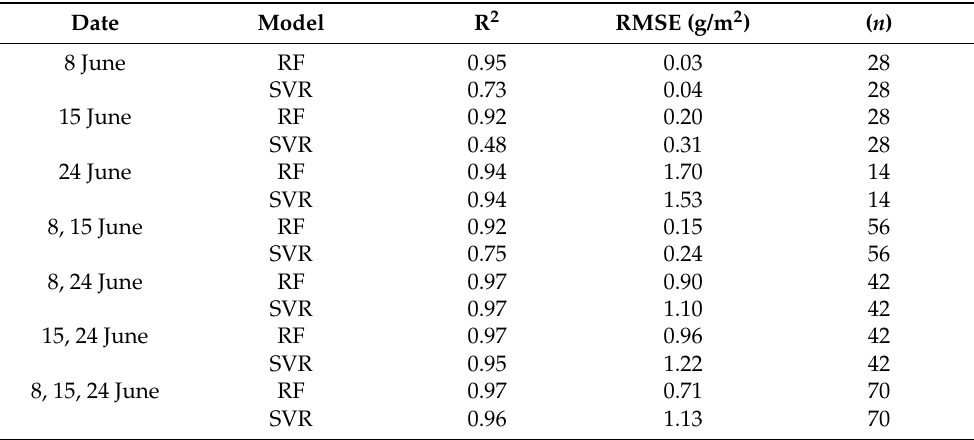
Table 4. Statistics for the calibration of the canopy nitrogen model with all 29 variables including vegetation indices, the 5 Micasense band reflectances, plant physiology variables, soil metrics, and topographic metrics, as a function of the date and the modeling approach (RF or SVR) 1 .